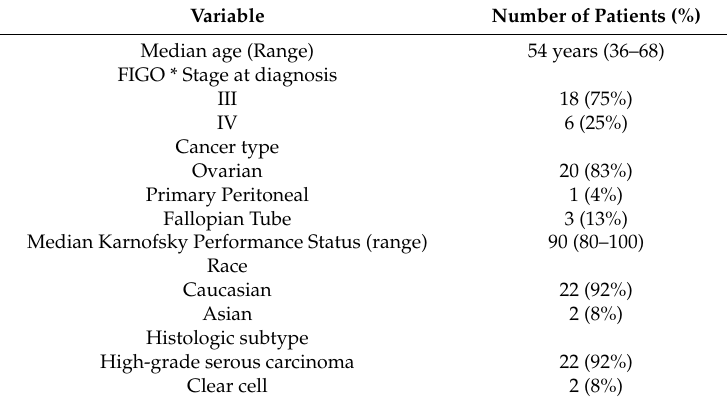
* FIGO = International Federation of Gynecology and